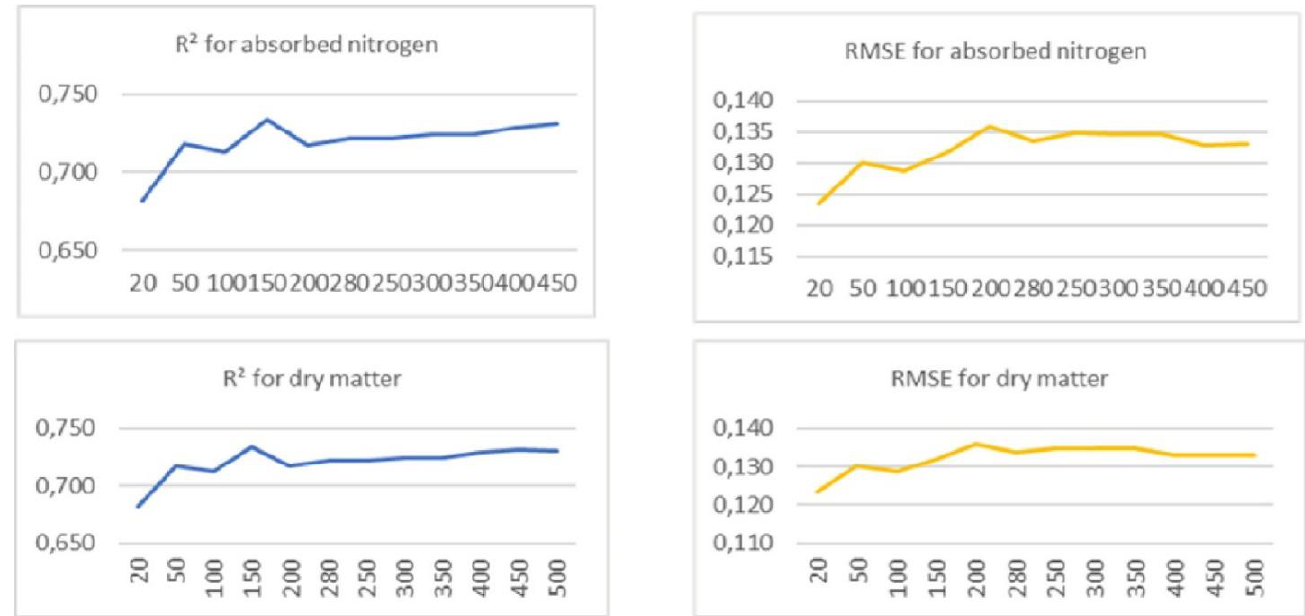
Figure 8. Iterative method for determining the number of trees n_estimators of Random Forest.